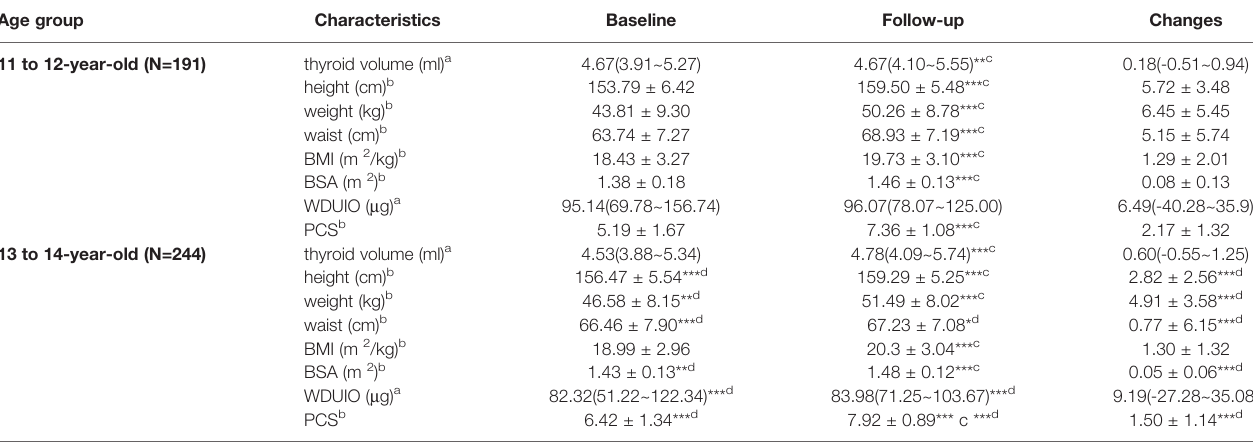
TABLE 1 | Distributions of Tvol, anthropometric indexes and other relative variables among 435 girls. Age